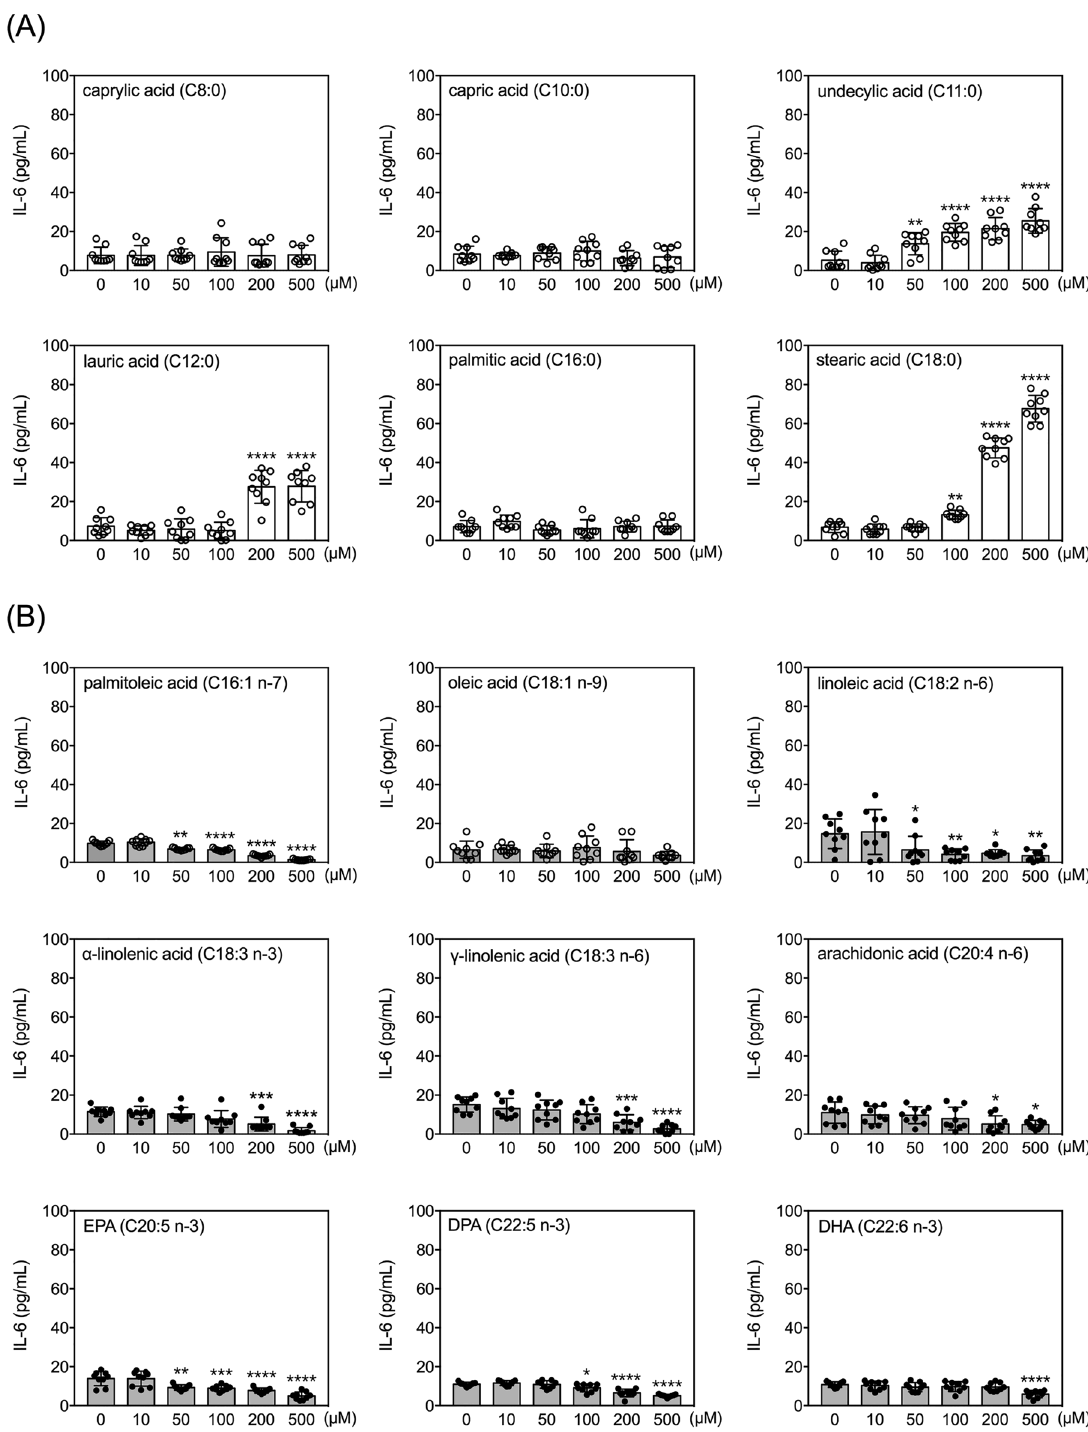
Figure 5. Effects of fatty acids on IL-6 secretion by human THP-1 monocytes. Quantitative results of levels of IL-6 in the conditioned media of THP-1 cells treated with selected FAs at different doses for 24 h. Data are presented as mean ± standard deviation. * p < 0.05, ** p < 0.01, *** p < 0.001, **** p < 0.0001, versus 0 µM vehicle group, Dunnett’s multiple comparisons after one-way ANOVAs. n =